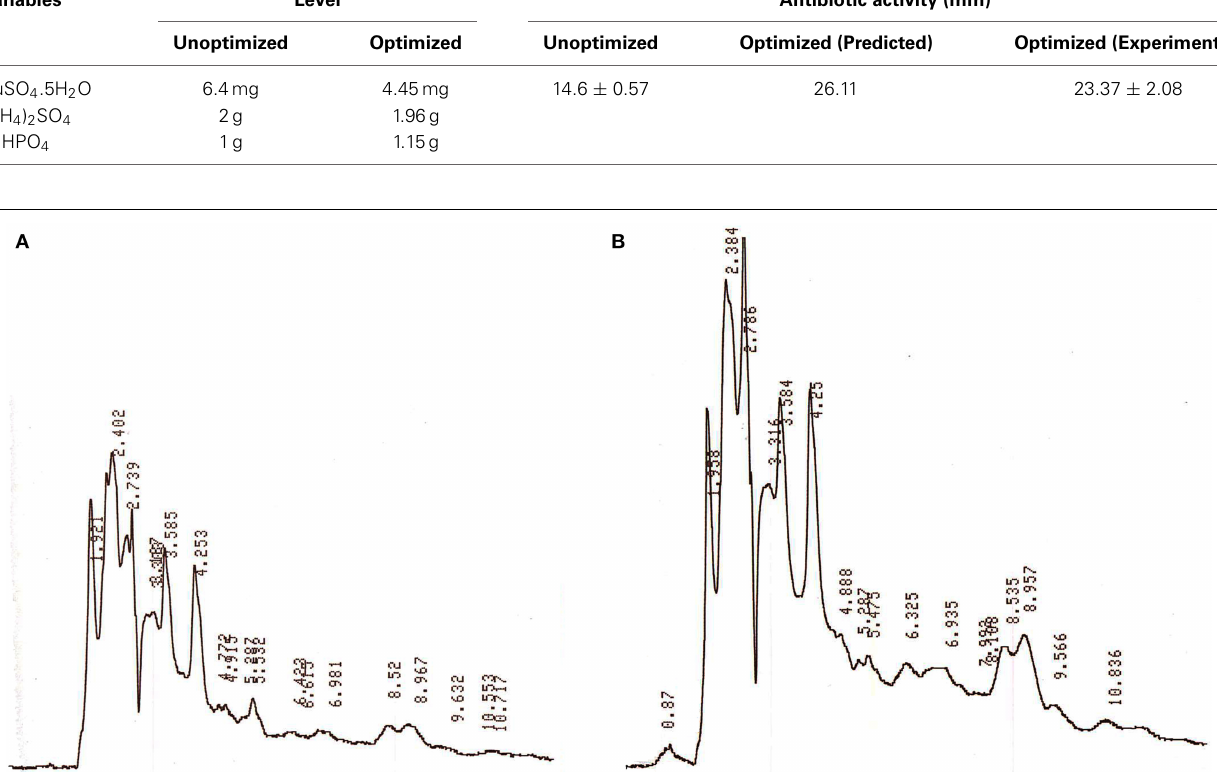
Table 9 | Combined effects of variables under their optimized and unoptimized levels on the antibacterial activity of Streptomyces sp. JAJ13. Variables